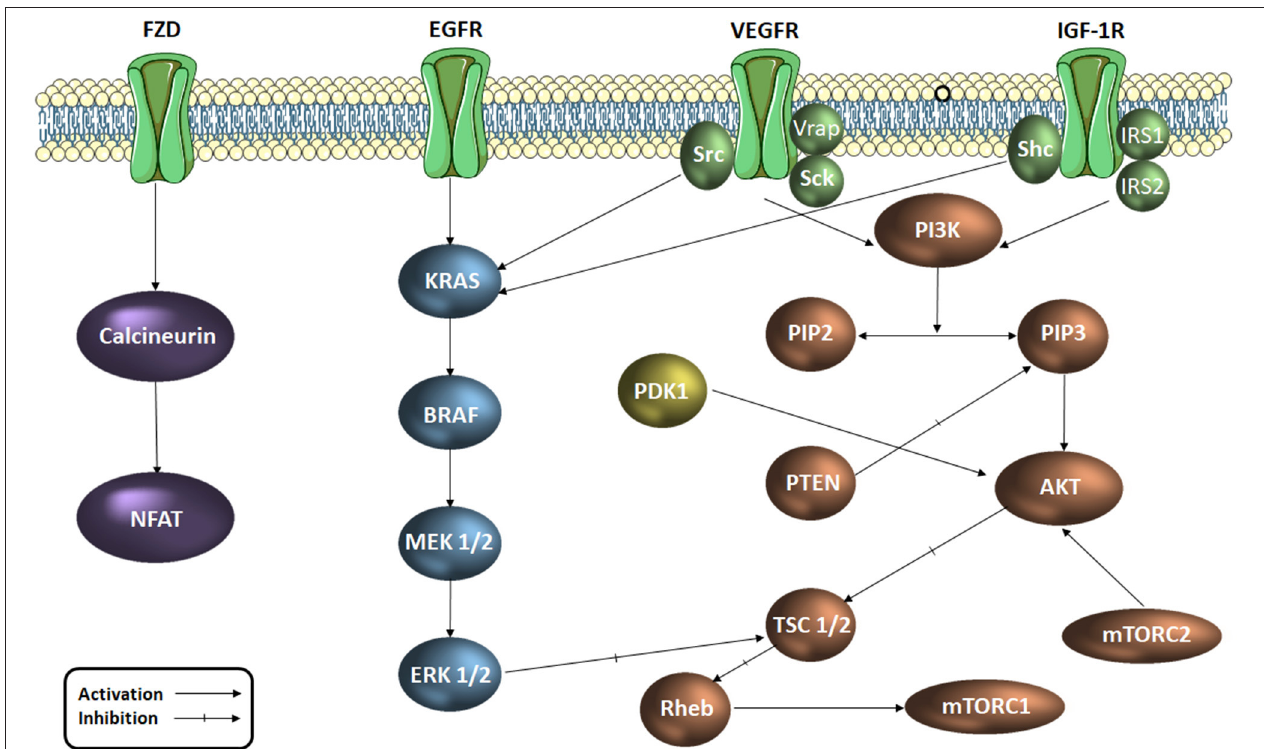
FIGURE 1 | Signaling pathways in colorectal cancer (simplified scheme). AKT, protein kinase B; RAF, serin/treonin-protein kinase proto-oncogen ˘ a ; RAS, retrovirus-associated DNA sequences; EGFR, epidermal growth factor receptor; ERK, extracellular regulated kinase; FZD, frizzled receptor; IGF-1R, insulin growth factor receptor 1; IRS, insulin receptor substrate; MAPK, mitogen activated protein kinase Mtorc, mammalian target of rapamycin complex; NFAT, factorul nuclear de activare a celulelor T; PDK1, phospholipid-dependent kinase 1; PI3K, phosphatidylinositol 3-kinaze; PIP2, fosfatidil-inozitol-difosfat; PIP3, fosfatidil-inozitol-trifosfat; PTEN, Phosphatase and tensin homolog; Rheb, Ras homolog enriched in brain; TSC, tuberous sclerosis protein; Shc, SHC-transforming proteins, VEGFR, vascular endothelial growth factor receptor; Vrap, VEGF Receptor-Associated